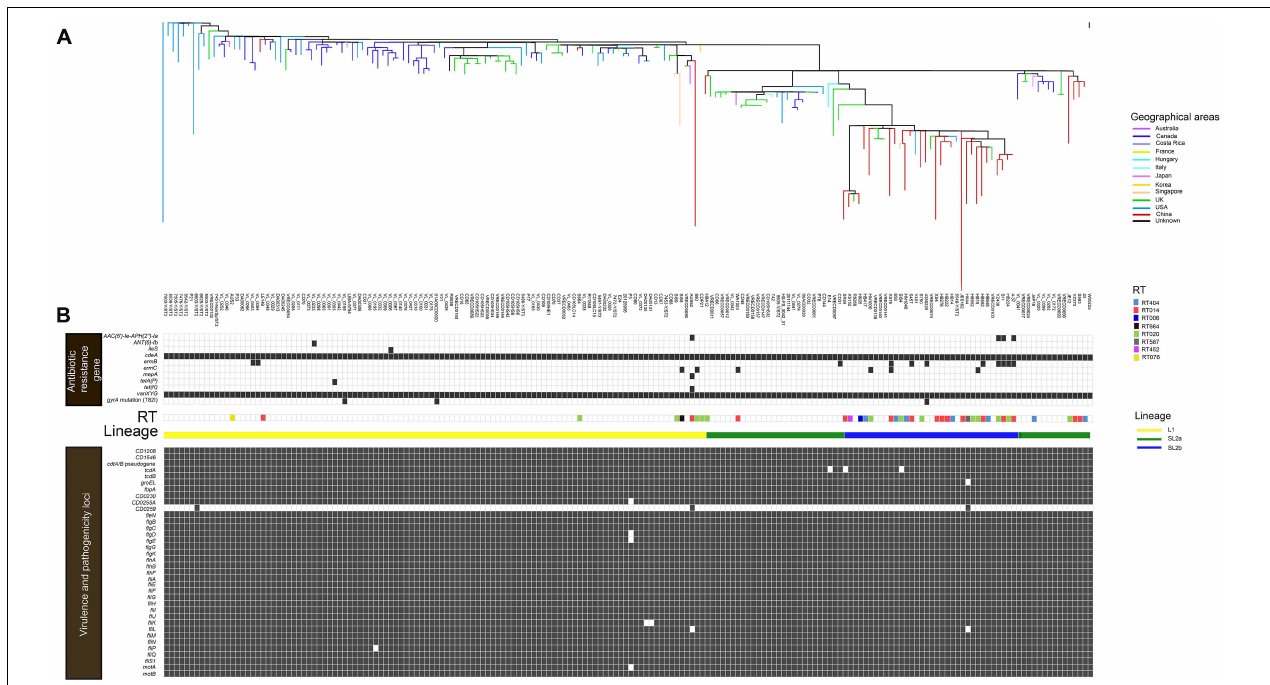
FIGURE 1 | In silico predicted antibiotic resistance genes and virulence loci of 182 C. difficile ST2 strains. The heat map showed the distribution of antibiotic resistance genes and virulence loci in the genome-wide data. (A) The phylogenetic tree. The different colors in the figure represent the different origins. (B) Presence is indicated by black bars and absence by white bars. Colored by RT: light blue, RT404; orange, RT014; navy blue, RT006; black, RT664; green, RT020; gray, RT587; rose red, RT452; and yellow, RT076. Sorted by lineage: yellow line, L1; green line, SL2a; and blue line, SL2b.